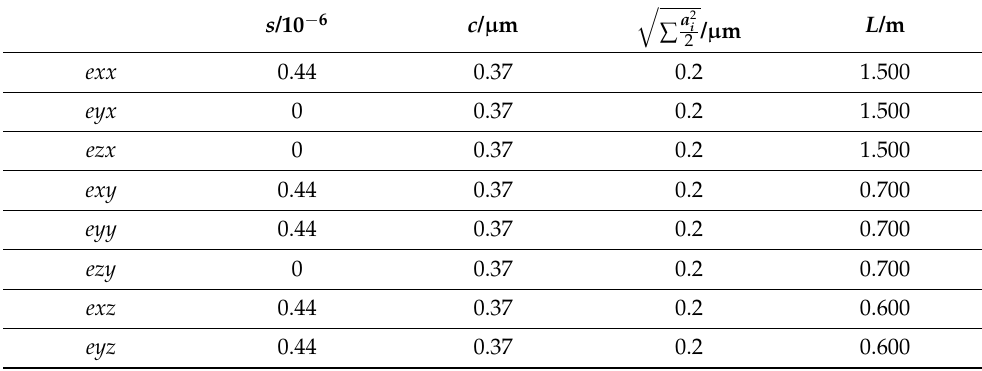
Figure 2. Example of positional and straightness errors of a single simulation of a virtual CMM. Table 1. Parameters used to simulate the positional and straightness errors of Figure 2.